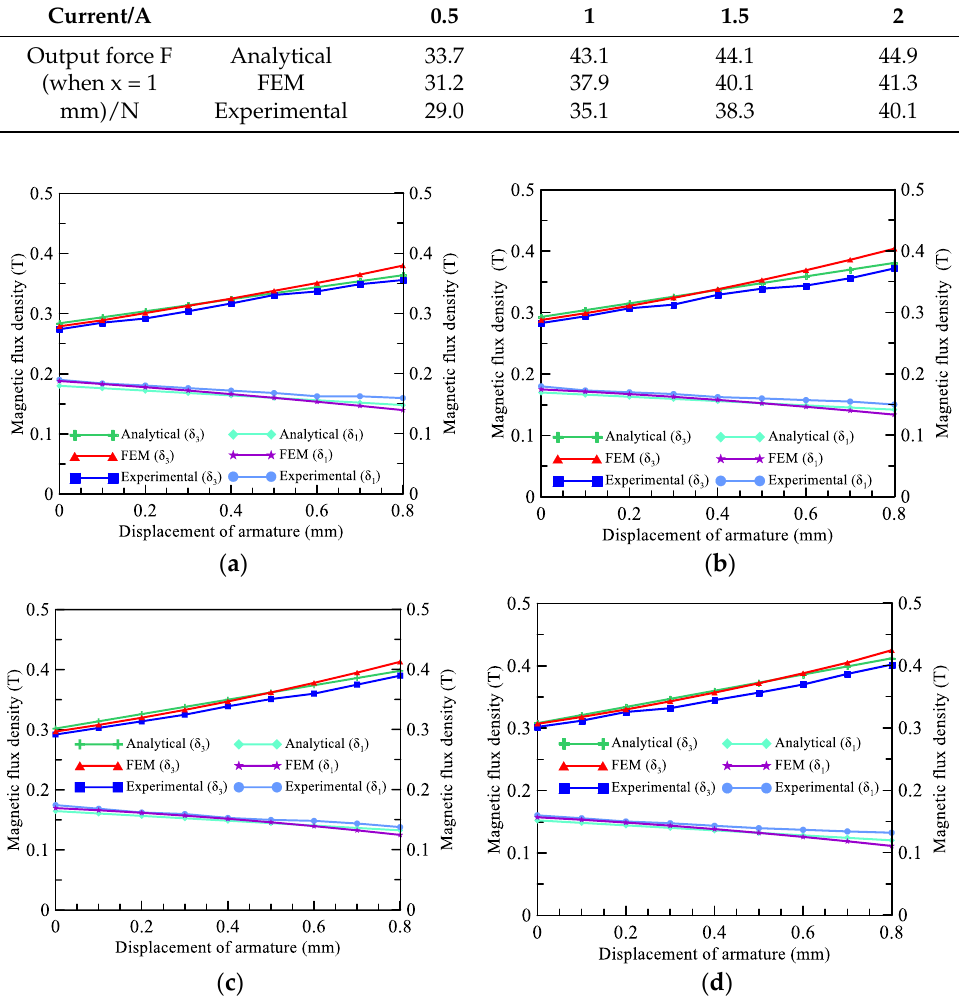
Table 7. Summary of the maximum output force.